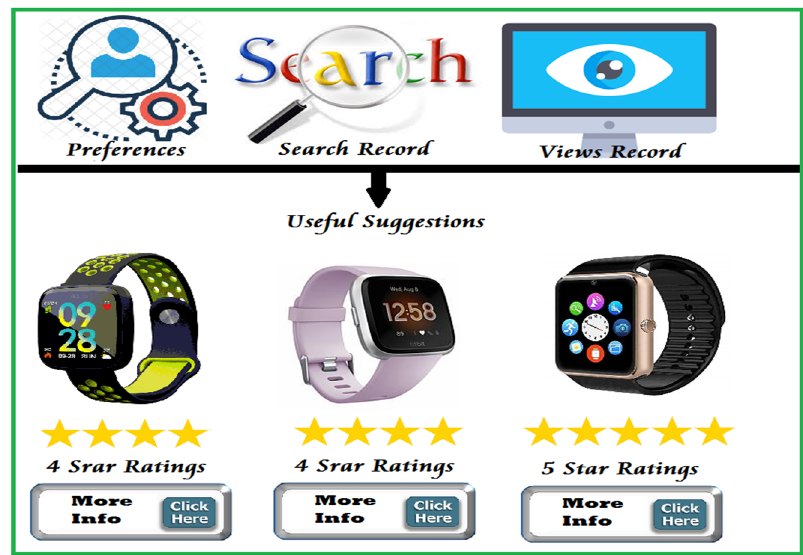
Figure 7. Example for recommending a user using items similarities.